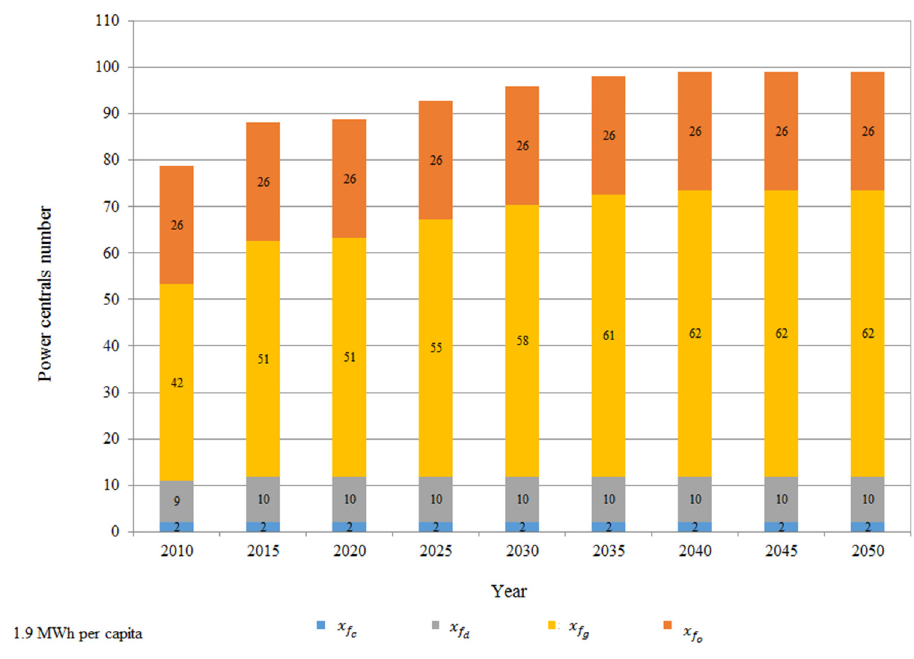
Figure 15. Optimized power plants number from fossil energy resource for 1.9 MWh per capita demand with the CVF model.